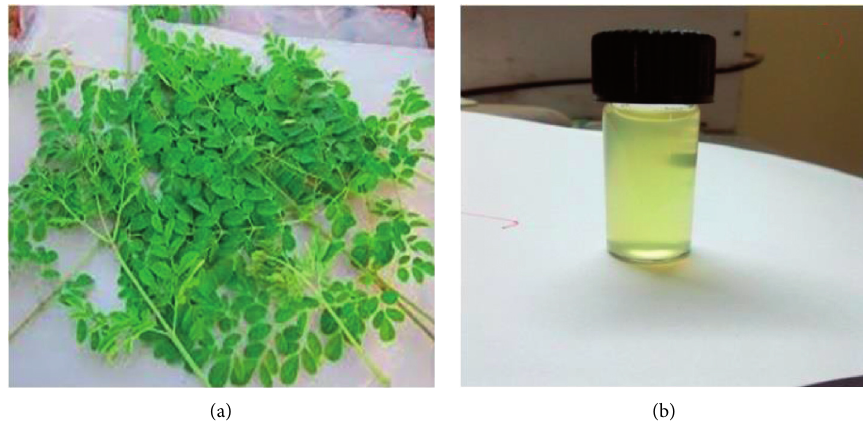
Figure 1: Moringa oleifera leaves (a) and aqueous Moringa oleifera leaf extract (b).